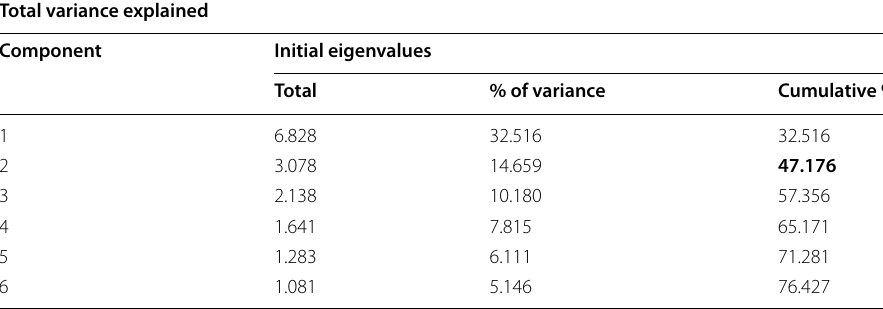
Table 1 The highest components of PCA for the first runs Total variance explained Component Initial eigenvalues Total % of variance Cumulative